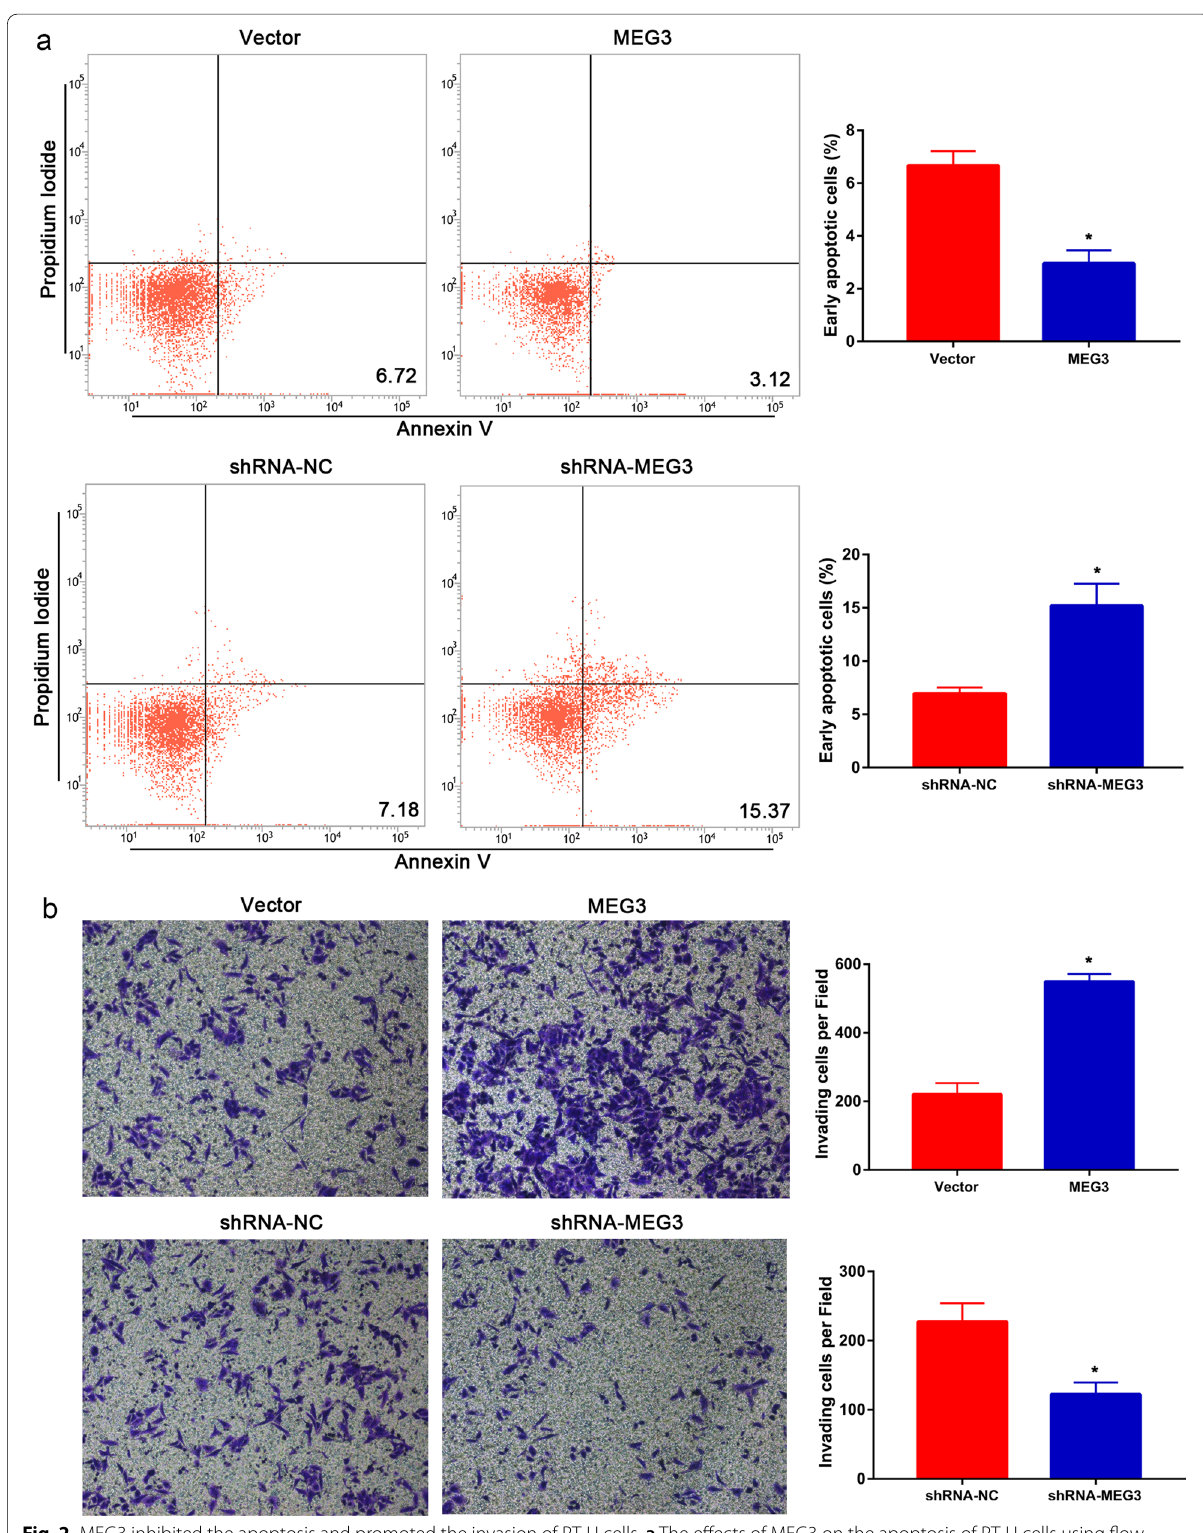
Fig. 2 MEG3 inhibited the apoptosis and promoted the invasion of PT-U cells. a The effects of MEG3 on the apoptosis of PT-U cells using flow cytometry assay. b The effects of MEG3 on the invasive capacity of PT-U cells using Transwell invasion assay (*P <